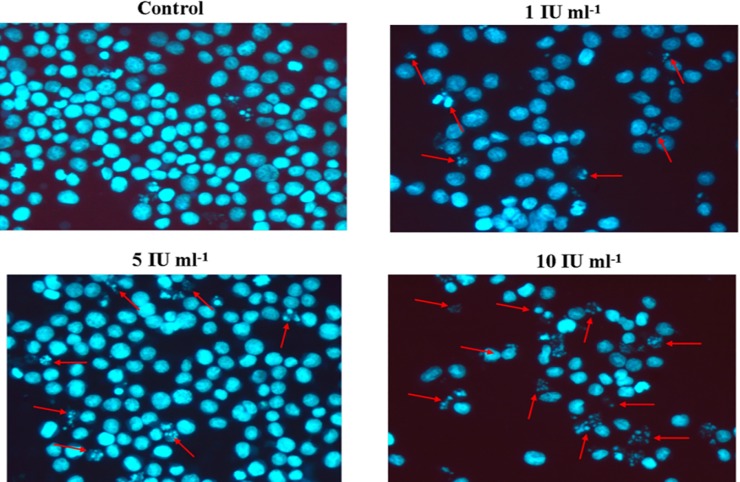
Alteration in nuclear morphology by treatment with purified E. cloacae asparaginase.HL-60 cells were treated with different concentrations of E. cloacae asparaginase, collected after centrifugation at 1600 rpm, washed once with PBS, and then stained with DAPI for 10 min. The procedure is discussed in Materials and Methods.